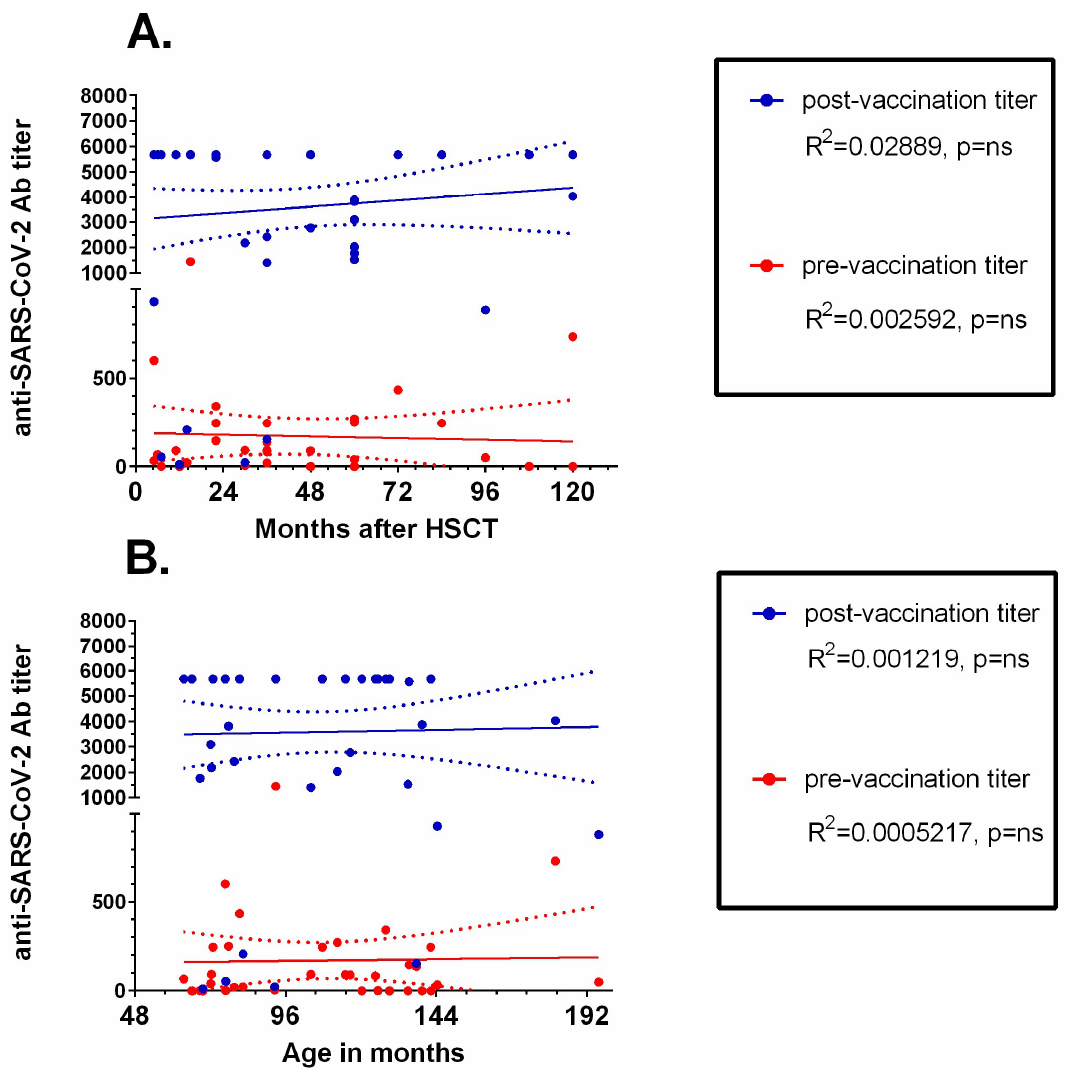
Figure 4. Linear regression analysis of anti-SARS-CoV-2 IgG concentration and ( A ) time since HSCT and ( B ) age of the patient. Trend lines are shown as continuous lines, and dotted lines represent 95% confidence intervals. ns: non-significant.